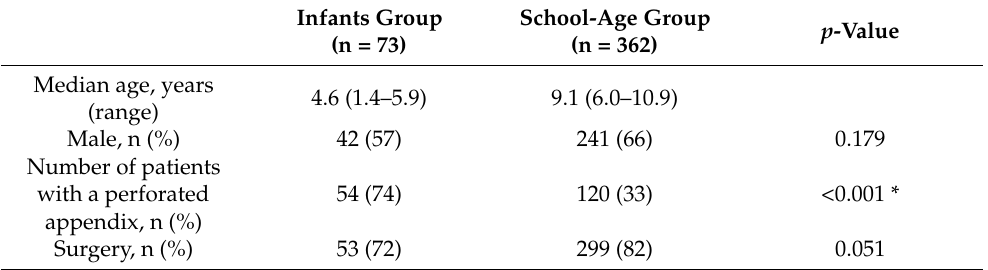
Table 1. Demographic data of infants and school-age children.